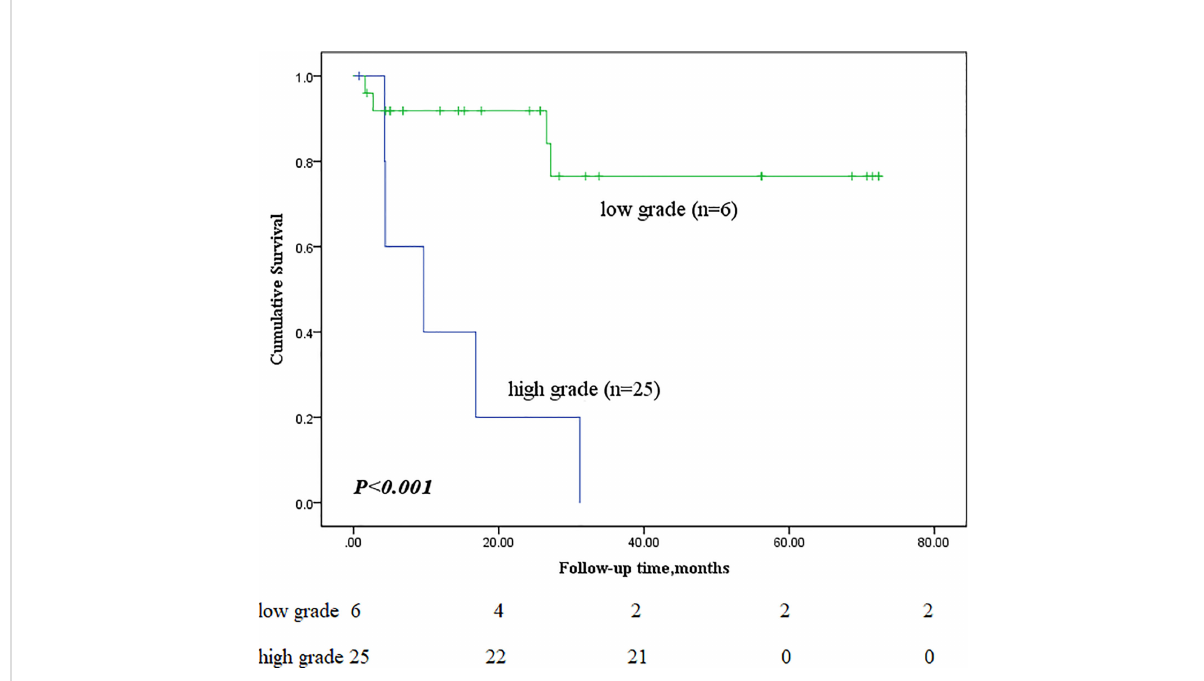
FIGURE 7 Comparison of primary outcomes between mucoepidermoid carcinoma patients with low-grade and high-grade